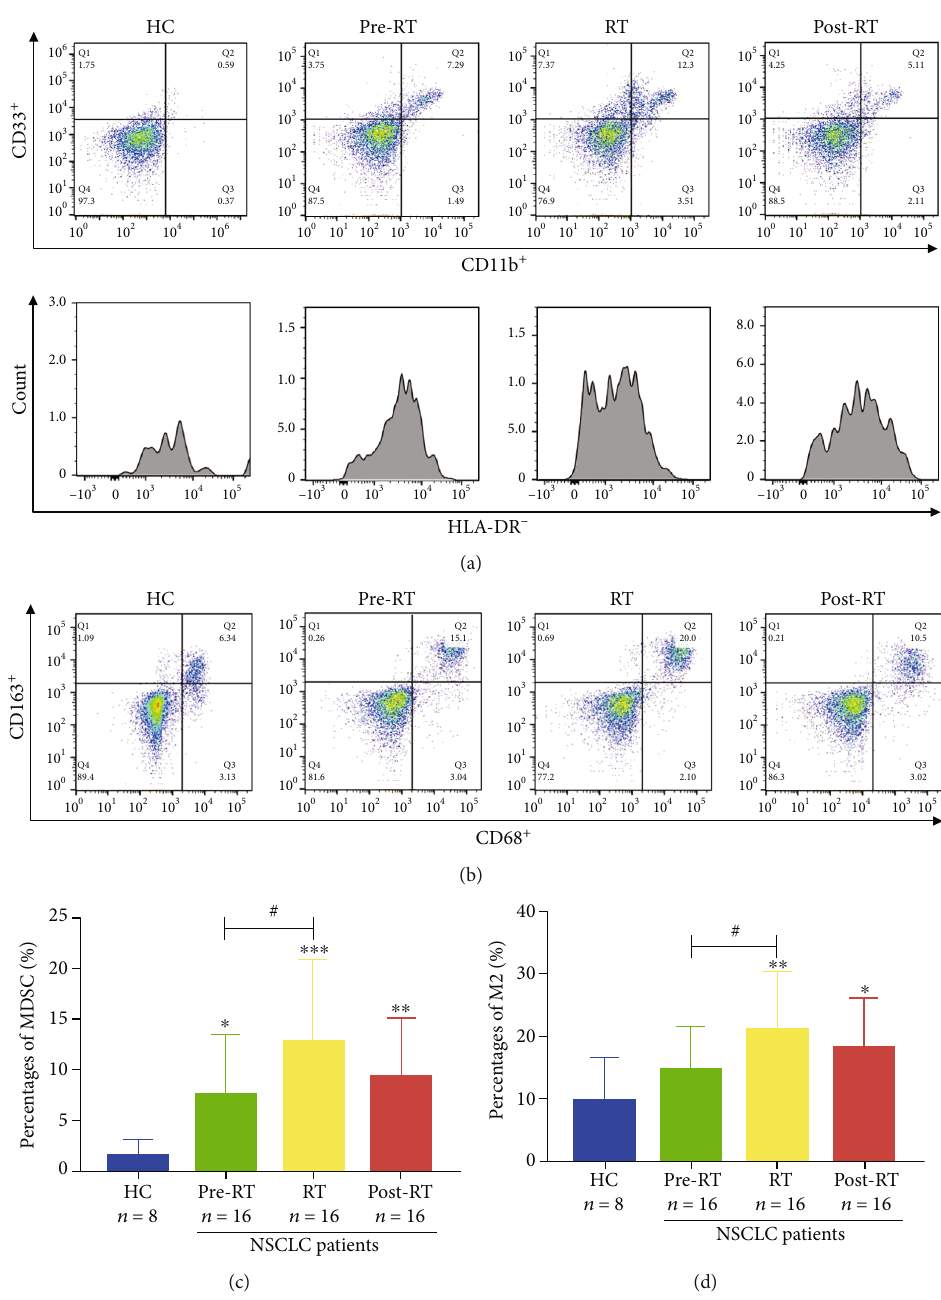
Figure 1: Peripheral MDSCs and CD68 + CD163 + M2-like macrophages in HC and NSCLC patients. (a, b) Representative dot plots and peak plots of CD11b + CD33 + HLA-DR − MDSCs and CD68 + CD163 + M2-like macrophages in HC and NSCLC patients. (c, d) The percentages of peripheral MDSCs and CD68 + CD163 + M2-like macrophages were signi fi cantly elevated in NSCLC patients. ∗ p < 0 : 05 , ∗∗ p < 0 : 01 , and ∗∗∗ p < 0 : 001 , compared to HC in two-tailed Student ’ s t -test. # p < 0 : 05 . The bars denote mean ± SD